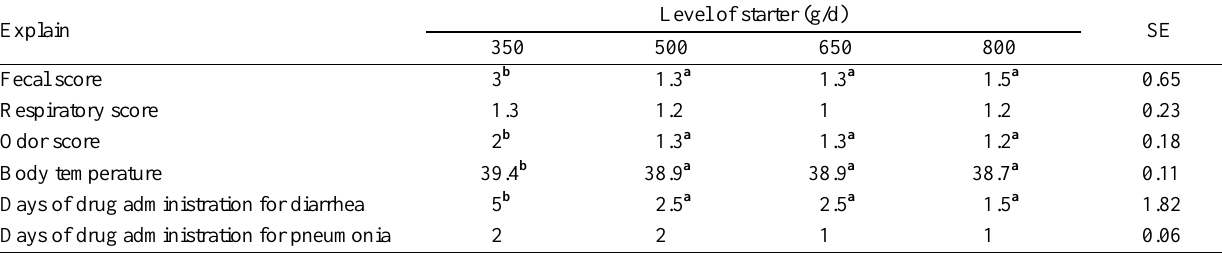
Table 5. Effects of levels of starter on health parameters